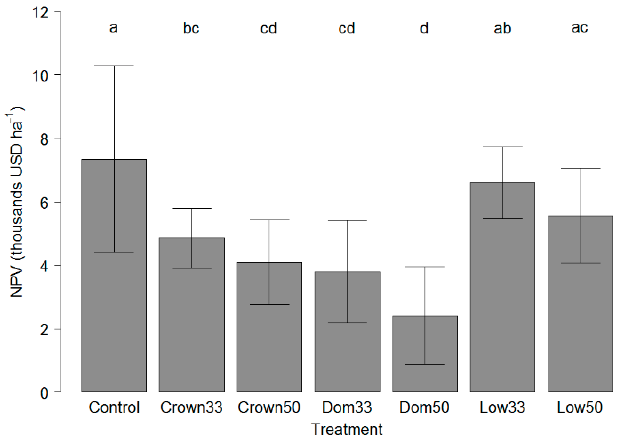
Figure 3. Maximum net present value (NPV) for all treatments and control including error bars (one standard deviation). Letters above the bars indicate statistically significant differences between treatments and control. Table 4. ANOVA results for fixed and random effects on the effect of treatment on (a) maximum net present value (NPV); (b) stand age at time of maximum NPV; and (c) average stem size.